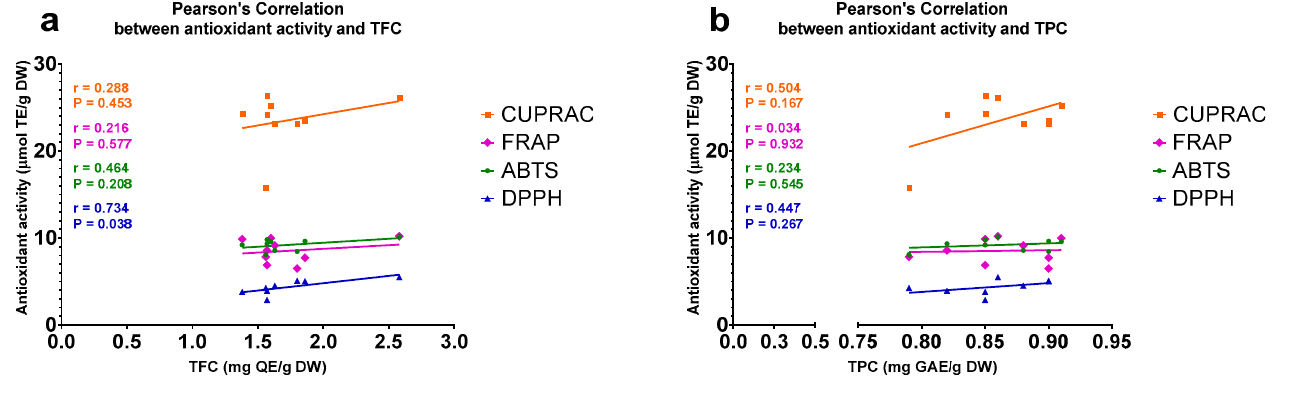
Figure 3. Scatter plot displaying Pearson’s correlations between antioxidant activities and ( a ) total flavonoid contents (TFCs) and ( b ) total phenolic contents (TPCs) of methanol extracts of A. compactum that were generated by ultrasonic-assisted extraction (UAE). The antioxidant activities of the extracts were measured by four independent assays. ABTS, 2,2 (cid:48) -azino-bis(3-ethylbenzothiazoline-6-sulfonate); CUPRAC, cupric ion reducing antioxidant capacity; DPPH, 2,2 (cid:48) -diphenyl-1-picrylhydrazyl; DW, dry weight; FRAP, ferric reducing antioxidant power; GAE, gallic acid equivalent; QE, quercetin equivalent; TE, Trolox equivalent.